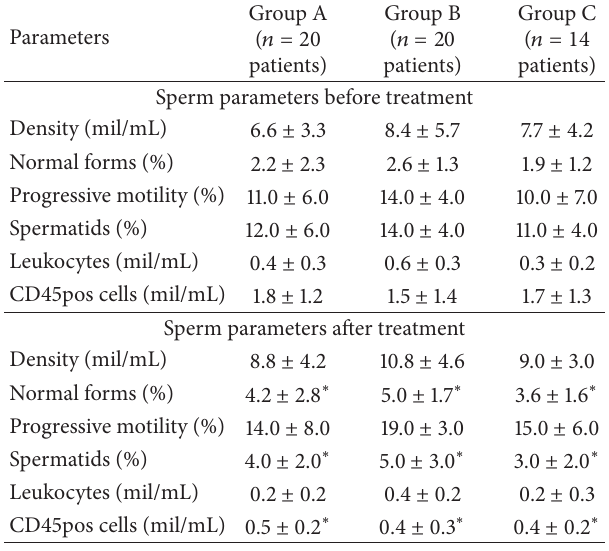
Table 3: Sperm parameters of the three examined groups before and after the hormonal treatment.